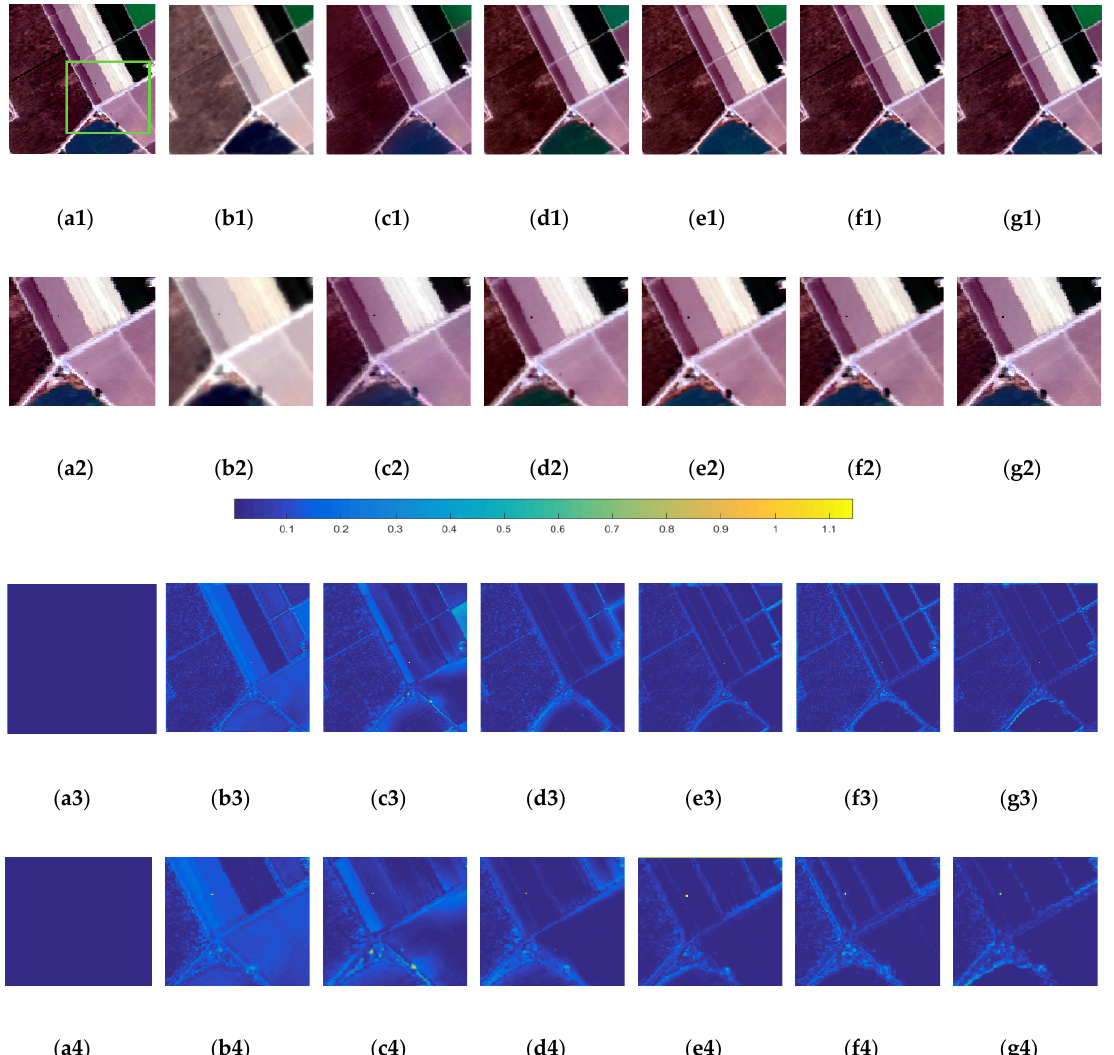
( g3 ) Figure 5. Experimental results obtained by each method for Washington DC dataset. ( a1–3 ) Reference image; ( b1–3 ) GS; ( c1–3 ) GFPCA; ( d1–3 ) CNMF; ( e1–3 ) HySure; ( f1–3 ) Bayesian; ( g1–3 ) HFWT. (First row (a1): reference HS image; First row (b1-g1): fused HS images; second row: enlarged subareas; third row (a3): reference error image; third row (b3-g3): error images between each fused HS image and the reference HS image.) Similar to the previous experiments, for the Salinas scene dataset, the fused results are shown in Figure 6. Figures 6a1, a2, and a3 show the reference HS image, the enlarged subareas of the reference HS image, and the reference SAM image, respectively. Figures 6b1-g1 in the first row show the subjective pansharpened results of each algorithm, and Figures 6b2-g2 in the second row display each enlarged subarea. The SAM images of each approach are shown in Figures 6b3-g3. The reference SAM image of enlarged subarea is shown in Figure 6a4, and the SAM images of enlarged subarea obtained by each method are shown in Figures 6b4-g4. The spectral distortion caused by the GS method is very obvious, and the degree of spatial enhancement is also not acceptable for the GS method, as depicted on Figure 6b1 and b2. Compared with the GS approach, the GFPCA method performs better in terms of the spectral quality. However, the fused HS image obtained by the GFPCA approach shows an indistinct area in the left region of Figure 6c1. Despite having a preeminent spatial quality, the CNMF method generates significant spectral distortion in the triangle region in the lower